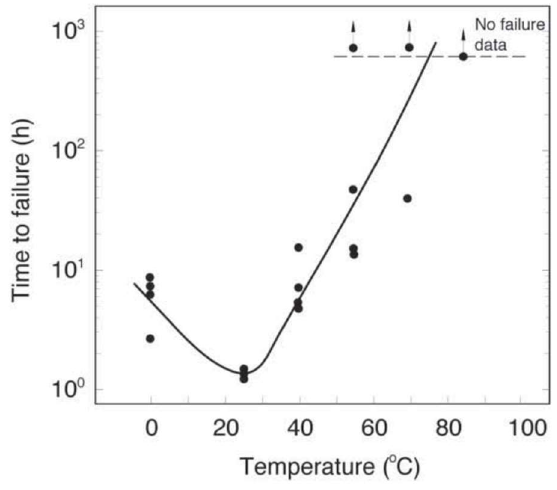
Figure 13. Time to sample failure vs. temperature [11].